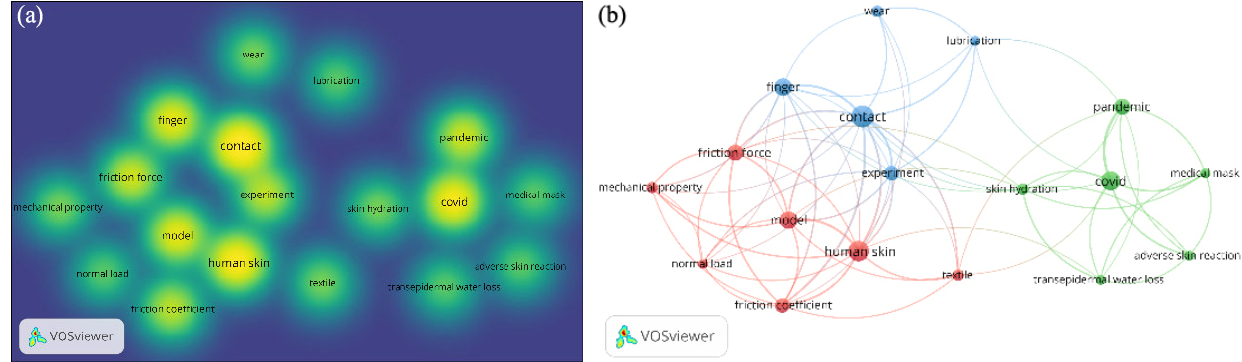
Fig. 41 (a) Density and (b) network diagrammes of skin